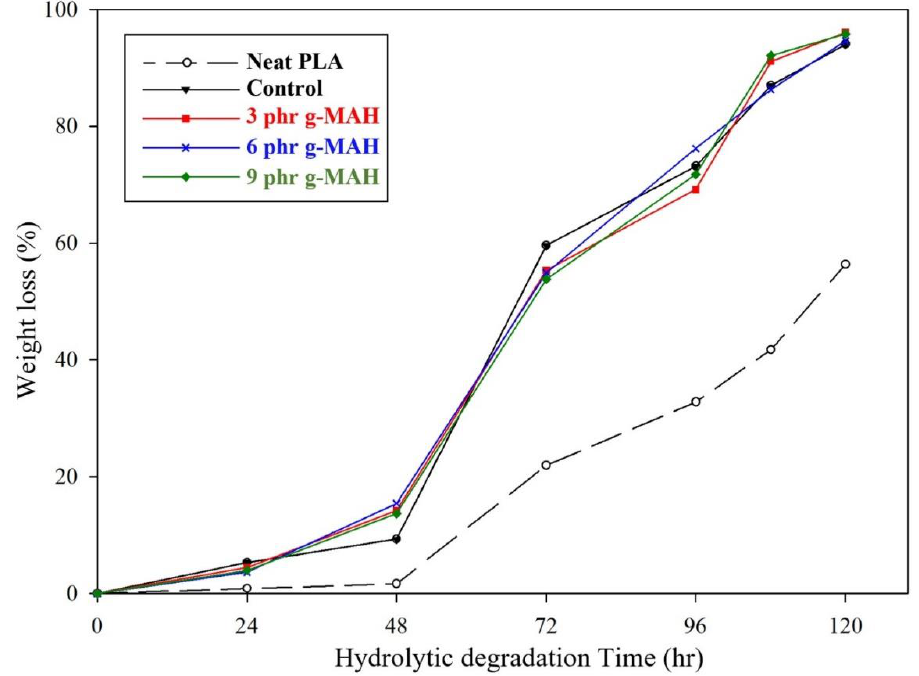
Figure 7. Hydrolytic degradation curves of neat PLA, PBSeT, and the PLA/PBSeT blend films with and without PLA-g-MAH.